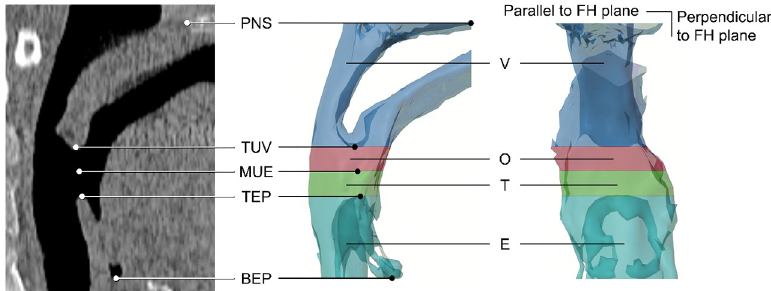
Fig 1. Location of the anatomic landmarks on the midsagittal plane and upper airway subregions of interest defined according to the landmarks. Landmarks: PNS, posterior nasal spine; TUV, tip of the uvula; MUE, midpoint between tip of the uvula and tip of the epiglottis; TEP, tip of the epiglottis; and BEP, base of epiglottis. Subregions: V, velopharynx region; O, oropharynx region; T, tongue base region; and E, epiglottis